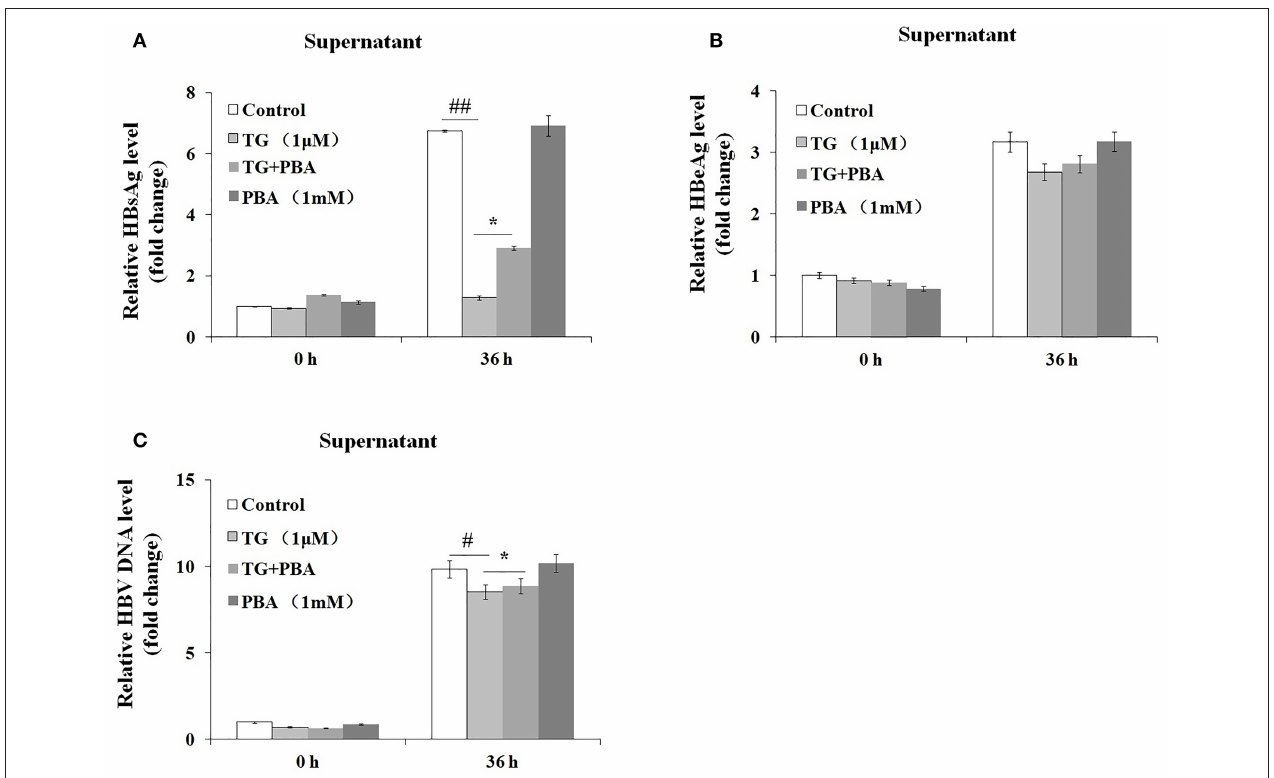
FIGURE 5 | 4-Phenylbutyric acid (PBA) pretreatment restored the secretion of hepatitis B virus (HBV) DNA, HBsAg, and HBeAg in HepG2.2.15 cells. HepG2.2.15 cells were treated with 1 µ M of thapsigargin (TG) with or without 1mM of PBA for 12, 24, 36, and 48h. The supernatant levels of HBsAg and HBeAg were determined by ELISA, while those of HBV DNA were determined by qPCR. The results are presented as fold-changes compared with the control. Histograms represent the means ± SD of three independent experiments. # P < 0.05 vs. the control ## P < 0.01, # P < 0.05 vs. the control; * P < 0.05. (A) HBsAg and (B) HBeAg levels as determined by ELISA. (C) HBV DNA levels as determined by